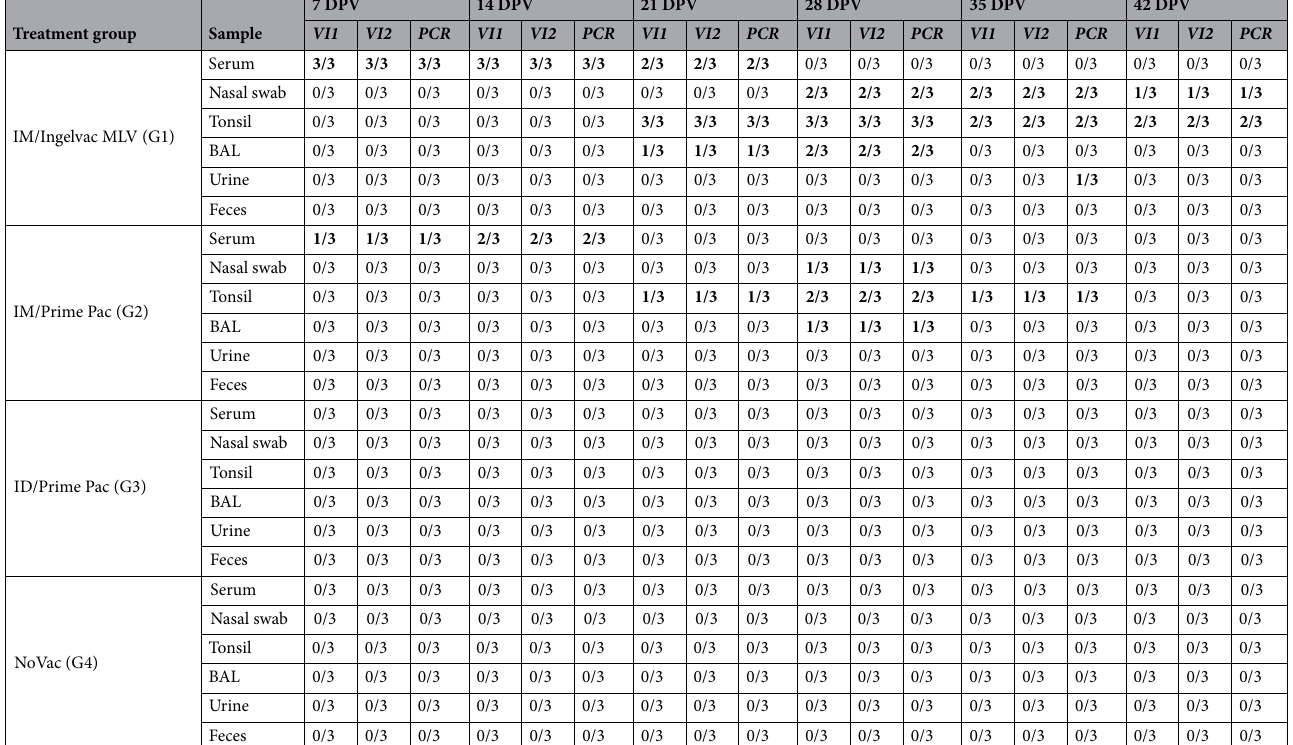
Table 3. PRRSV-positive samples of experiment A (Exp A) using virus isolation in cell culture and PCR. Values expressed as the number of the positive samples/total samples. Significant values are in [bold].